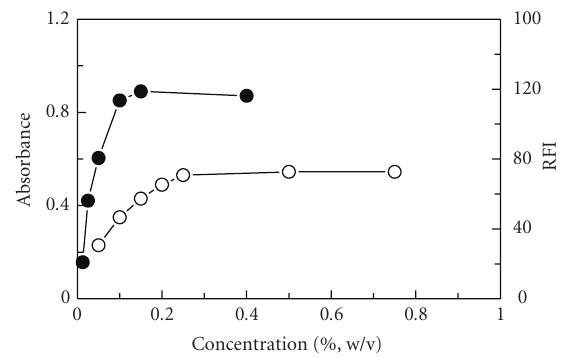
Figure 3: E ff ect of NQS ( • ) and NBD-Cl ( ◦ ) concentrations on their reaction with FLX. FLX concentrations were 3 and 0.02 μ gmL − 1 for its reaction with NQS and NBD-Cl, respectively. RFI is the relative fluorescence